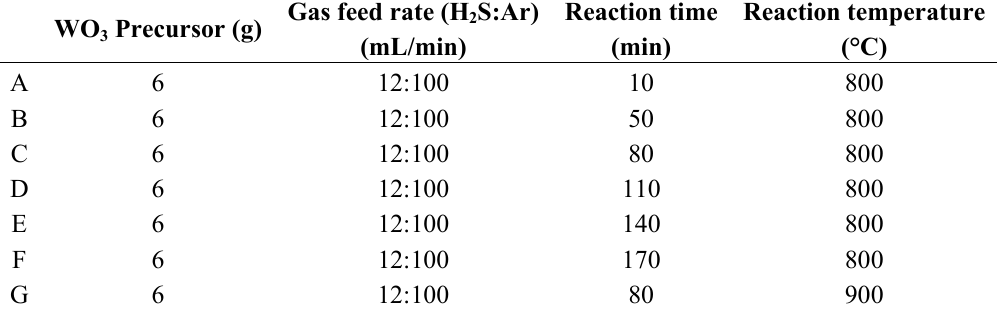
with varying reaction 2